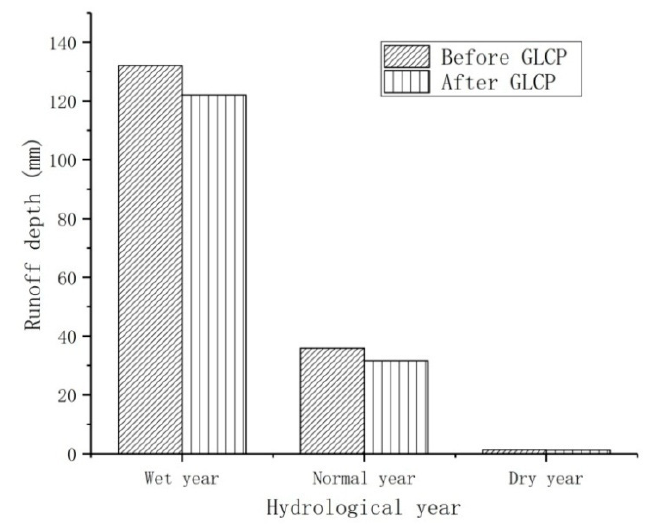
Figure 8. Annual surface runoff in different hydrological years before GLC (in 2013) and after GLC (in 2019).